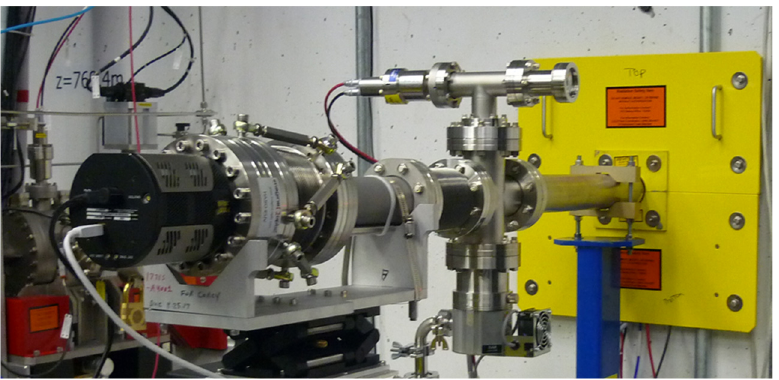
Figure 4. Soft X-ray wavefront sensor attached to the soft X-ray beamline at the Linac Coherent Light Source (LCLS). Reprinted with permission from [22].